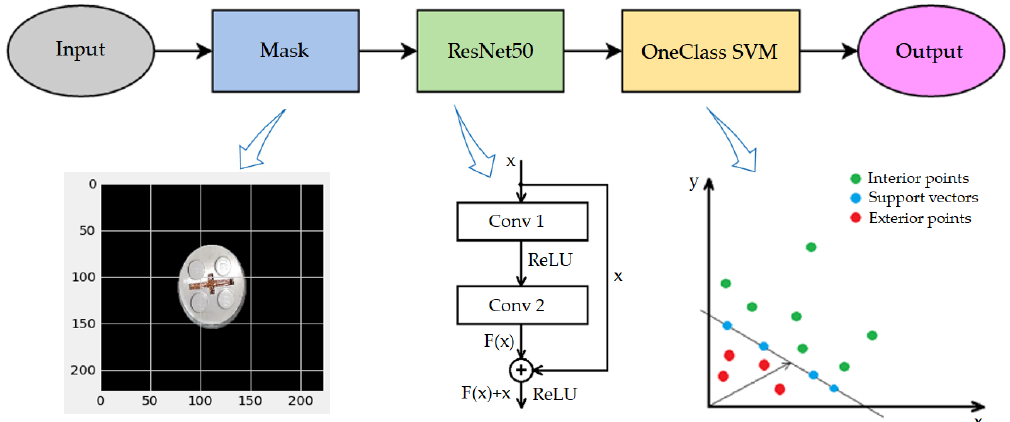
Figure 12. Proposed CNN architecture for one-class classification.